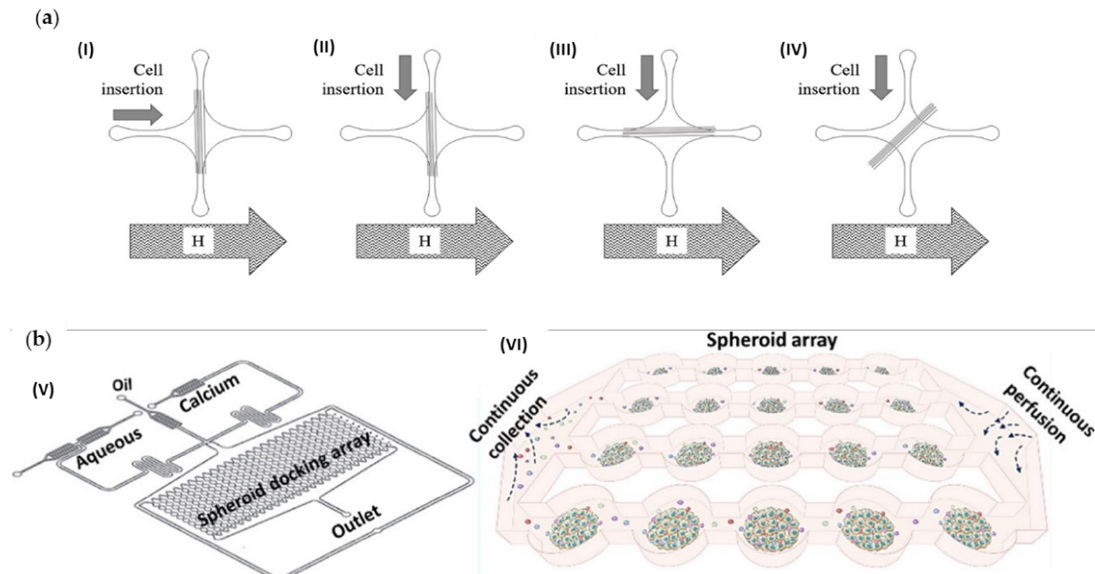
Figure 4. ( a ) Schematic representation of the microfluidic device developed by Mitxelena-Iribarren et al. [34] with microwires position perpendicular (I), (II), parallel (III), or diagonal (IV) regarding the magnetic field and orthogonal (I), (II), longitudinal (II) and diagonal (IV)) cell insertion regarding the microwires. Reprinted with permission from [34]. ( b ) Sabhachandani et al. [35] proposed the microfluidic device represented in (V) and (VI) representation of the microarray for spheroid cell culture. Reprinted with permission from